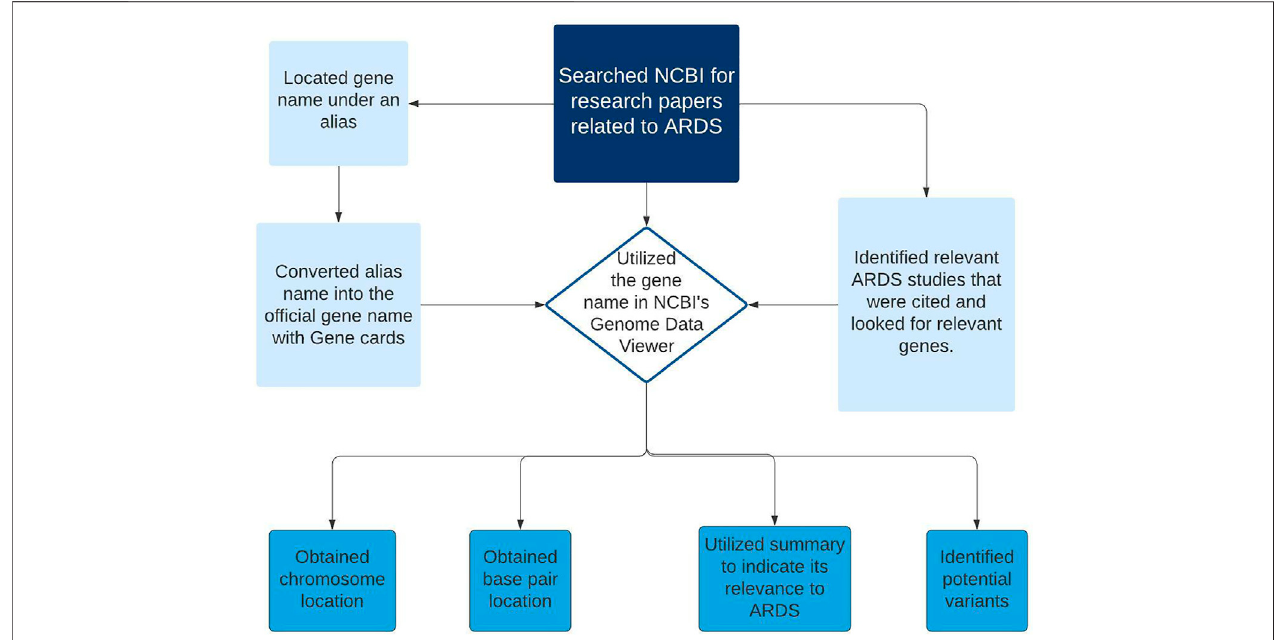
FIGURE 1 | Diagram showing the work fl ow steps (data collection and primary curation) for the development of ARDS DB.